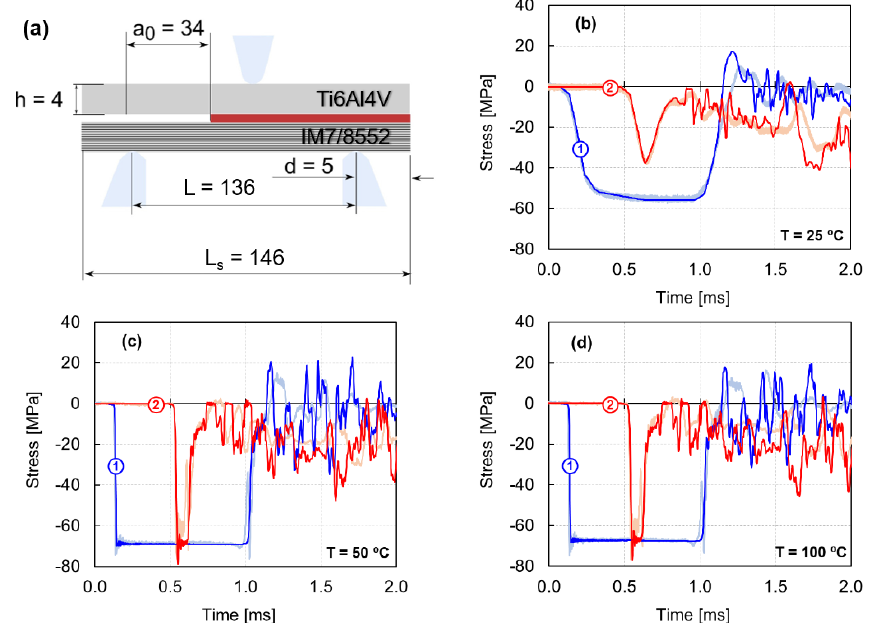
Figure 4. (a) Comparison of stress wave signal results for experiments (light) and simulations (dark) for temperatures of (b) 25 °C, (c) 50 °C and (d) 100